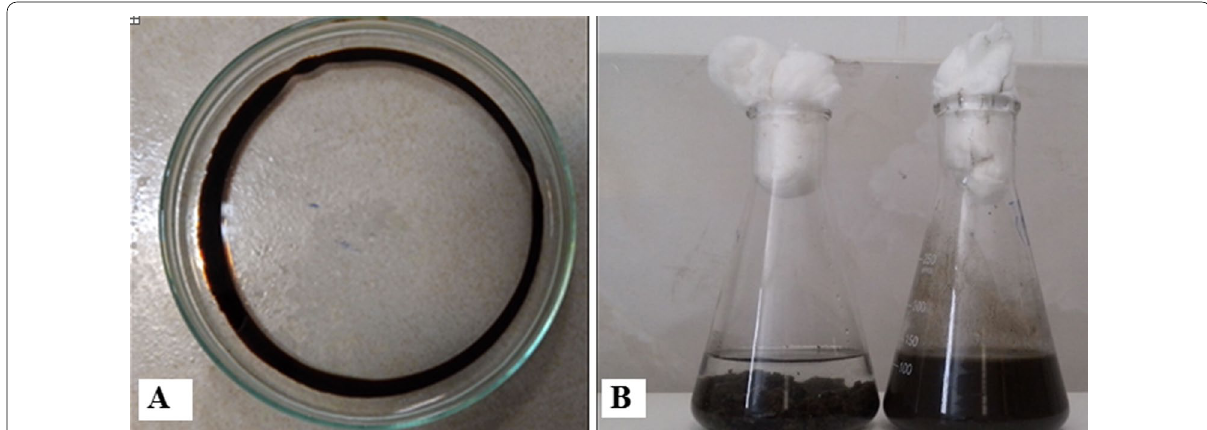
Fig. 1 A Oil displacement test by supernatant obtained from Kocuria rosea ABR6. B The emulsion stability of oily sludge obtained from culture medium of Kocuria rosea ABR6 after 7 days’